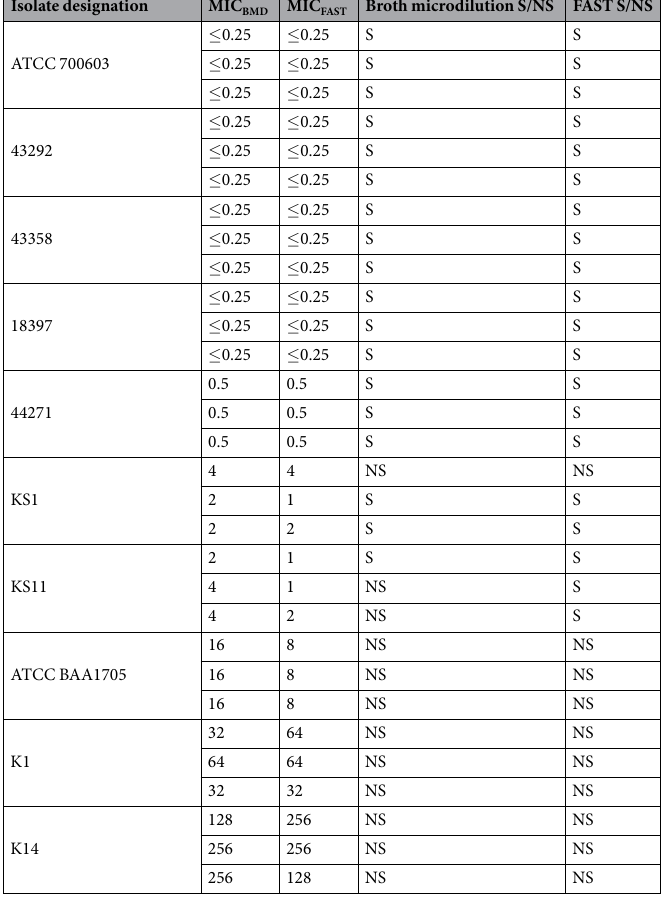
Table 1. Assay validation with 10 K. pneumoniae isolates exposed to meropenem. MIC FAST : FAST method MIC.